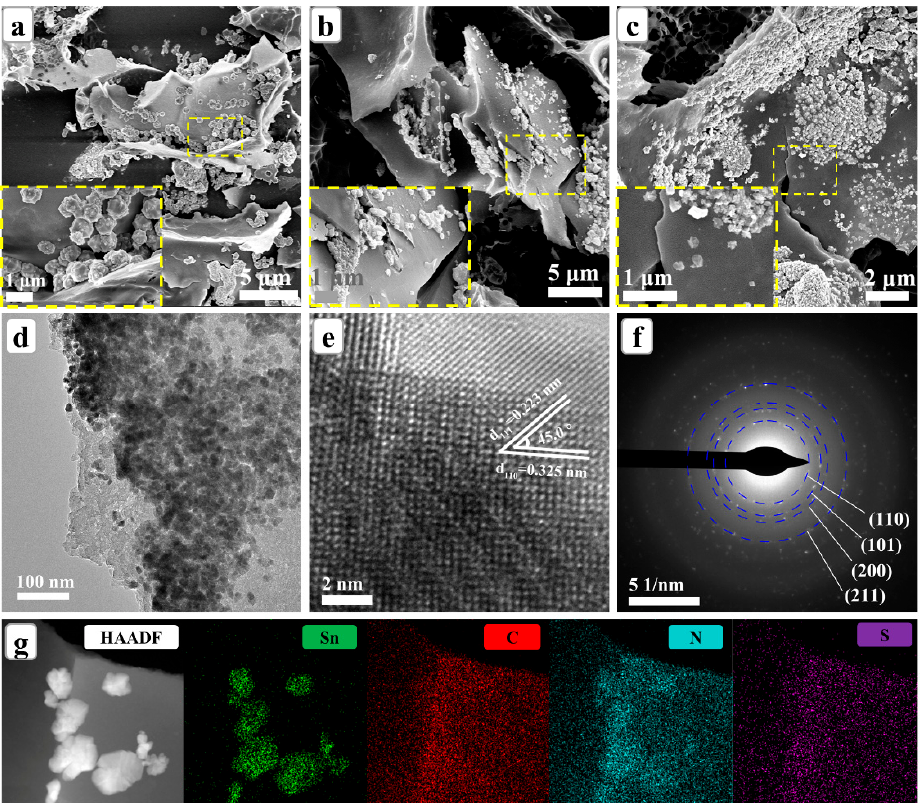
Figure 2. SEM images for the ( a ) SnO 2 @SNC − 2, ( b ) SnO 2 @SNC − 4 and ( c ) SnO 2 @SNC − 8 composite. ( d ) TEM image, ( e ) HRTEM and ( f ) SAED spectra of the SnO 2 @SNC − 8 sample. ( g ) HAADF image and elemental mapping for Sn, C, N and S element of SnO 2 @SNC − 8 composite.